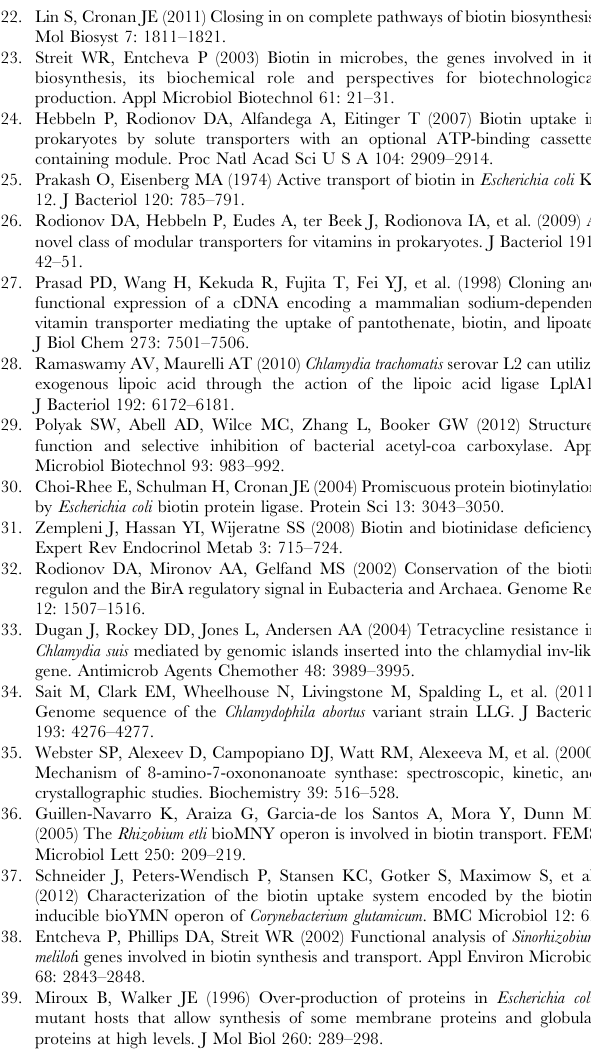
green channel micrographs. Cells were infected with C. trachomatis H56) micrographs were merged for panel C images and an example inclusion is marked with white arrows in each panel. Figure S9 Localization of SMVT in infected McCoy cells using immunofluorescence microscopy. McCoy cells were infected for 20–24 hours, fixed and permeablized, and probed with anti-SMVT (H56) antibodies (shown in red) and anti-IncA antibodies (shown in green). The inset in panel C was created by merging the red and green channel micrographs. The SMVT H56 antibody was raised against a C-terminal peptide from the human SMVT (amino acids 528–580). Species cross reactivity between the human and mouse SMVT was expected with H56 because the mouse peptide region shares 49/52 amino acids with the human antigenic peptide region. Table S1 Biotin acquisition and utilization genes in obligate intracellular bacteria.